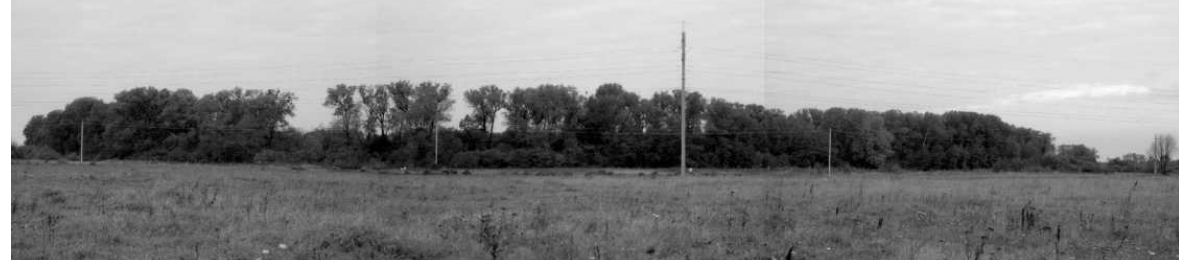
Fig 9 . Fort IV – view from Rokai district in 2006 (Photo by V.